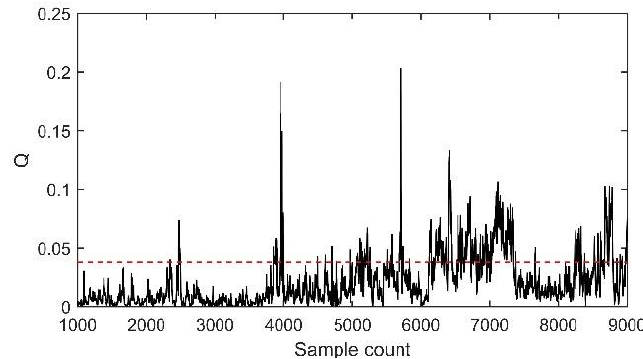
Figure 7. The Q -statistic of the EVT based on traditional PCA.